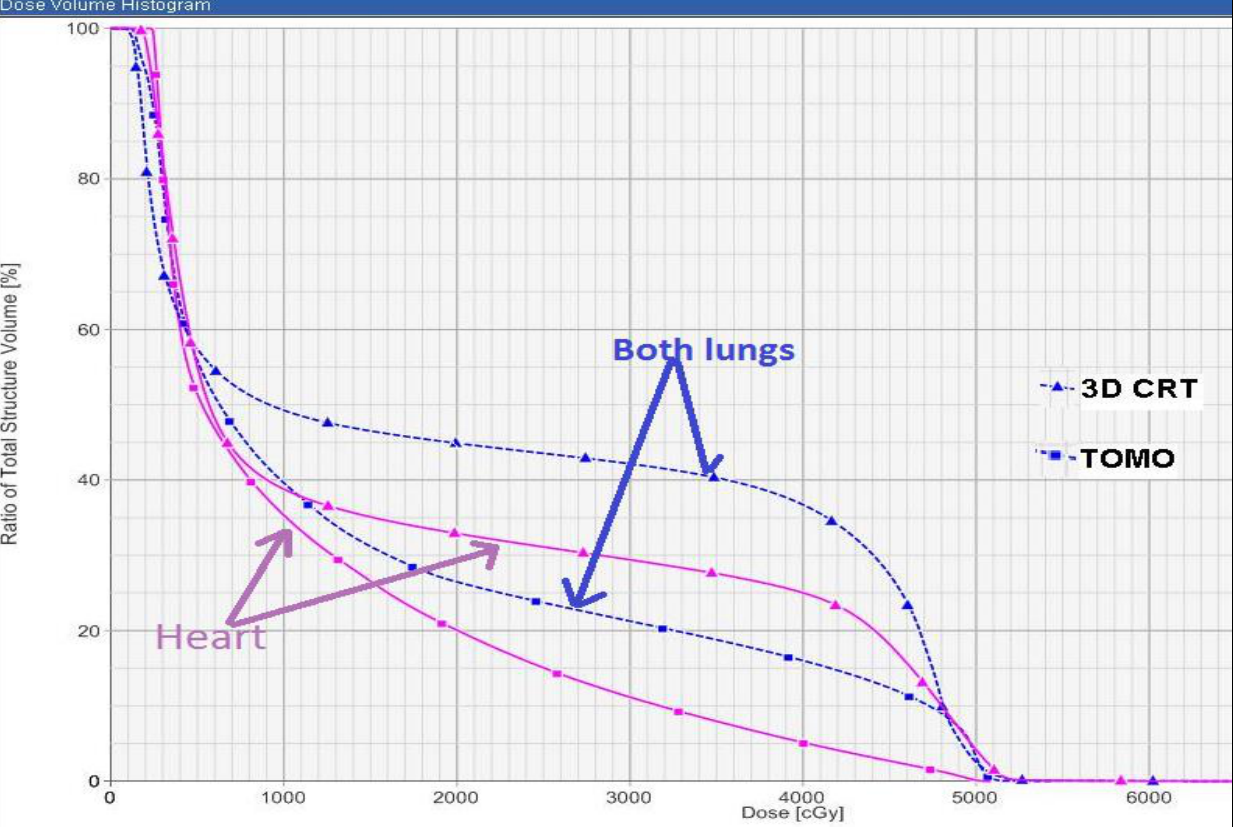
Figure 3: Dose volume histogram comparison between the 2 plans regarding doses to the heart and